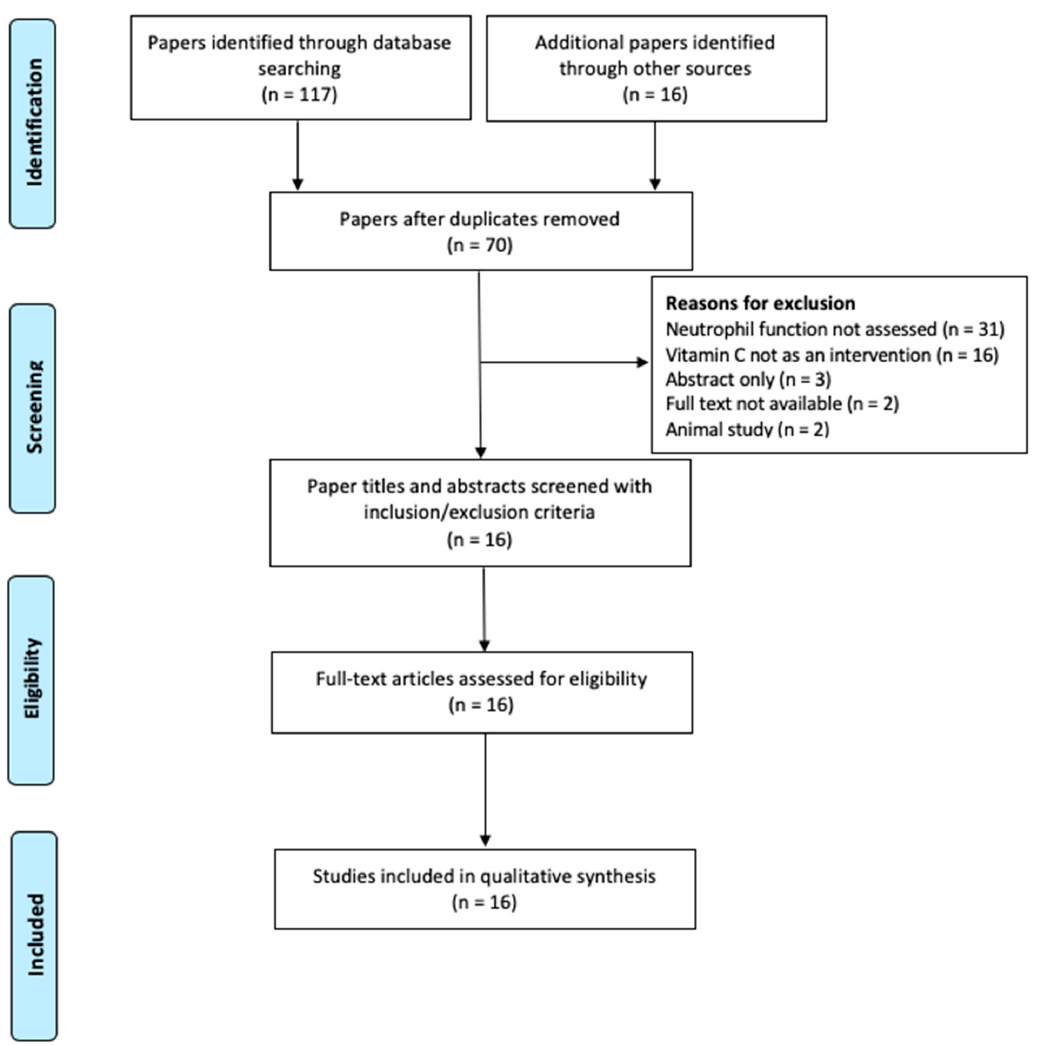
Figure 1. The study selection process presented using the PRISMA flow chart.